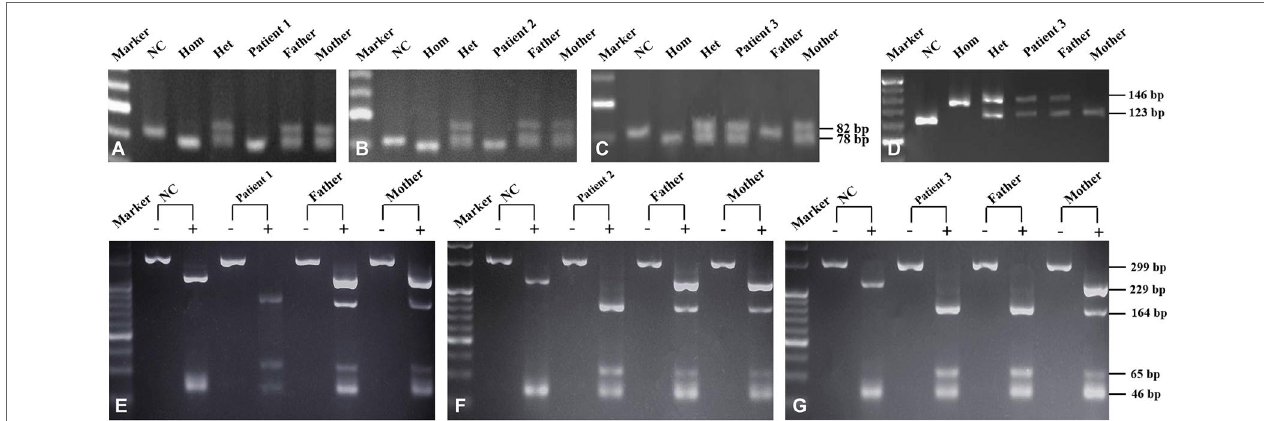
FIGURE 1 | SLC25A13 and SLC10A1 genetic analysis of the three families. SLC25A13 analysis revealed that patients 1 (A) and 2 (B) were both homozygotes of the c.852_855del4 mutation while patient 3 (C and D) , a compound heterozygote of the mutations c.852_855del4 and c.1638_1660dup. On SLC10A1 analysis, patients 1 (E) , 2 (F) , and 3 (G) as well as her father were all homozygotes, while the parents of patients 1 and 2 and the mother of patient 3, all carriers, of the variant c.800C>T(p.Ser267Phe). NC (normal control), Hom (homozygous control), Het (heterozygous control). The “-” and “+” over every lane in panels E – G represented with and without enzymatic digestion by using the HphI enzyme, respectively.